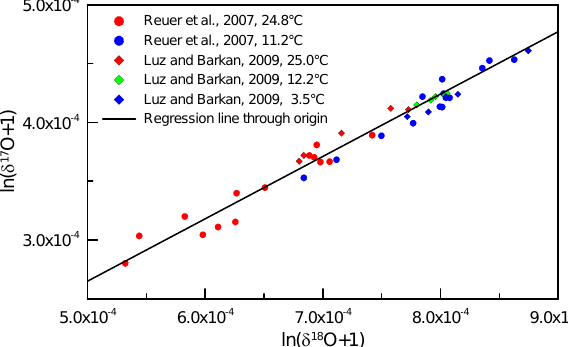
Fig. A3 17 O vs. 18 O of dissolved O 2 (Luz and Barkan, 2009; Reuer et al.,